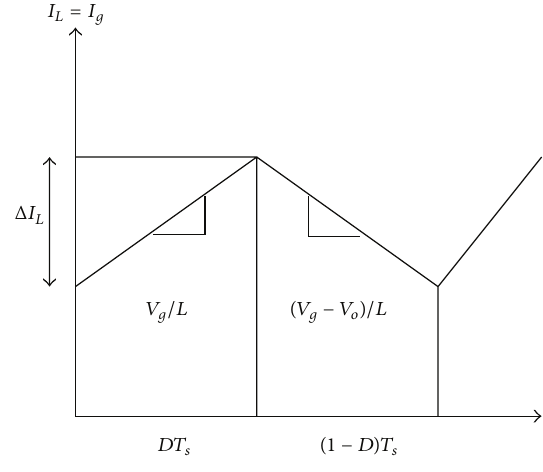
Figure 3: P-V output characteristic with different irradiance.